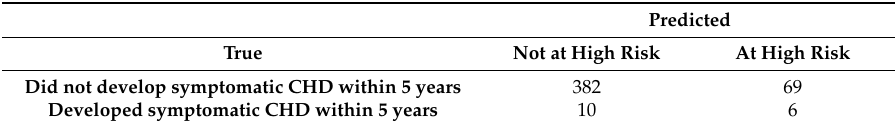
Table 6. The confusion matrix of the ASCVD risk estimator on the test dataset for predicting a high risk of developing symptomatic CHD within five